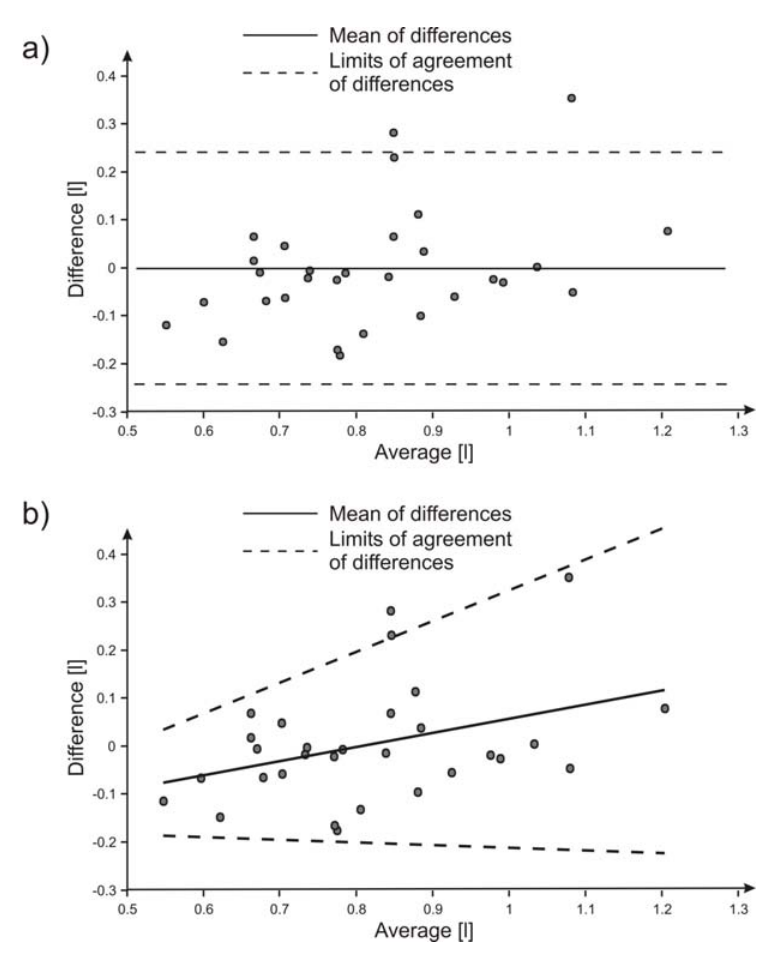
Figure 8 . Differences versus average for tidal volumes measured with two different methods: (a) mean and 95% limits of agreement considering uniform dispersion; (b) mean and 95% limits of agreement with regression